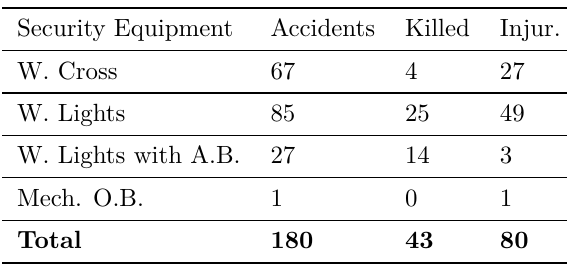
Table 1. Number of Traffic Accidents on Level Cross- ings According to the Type of Security Equipment (2014)